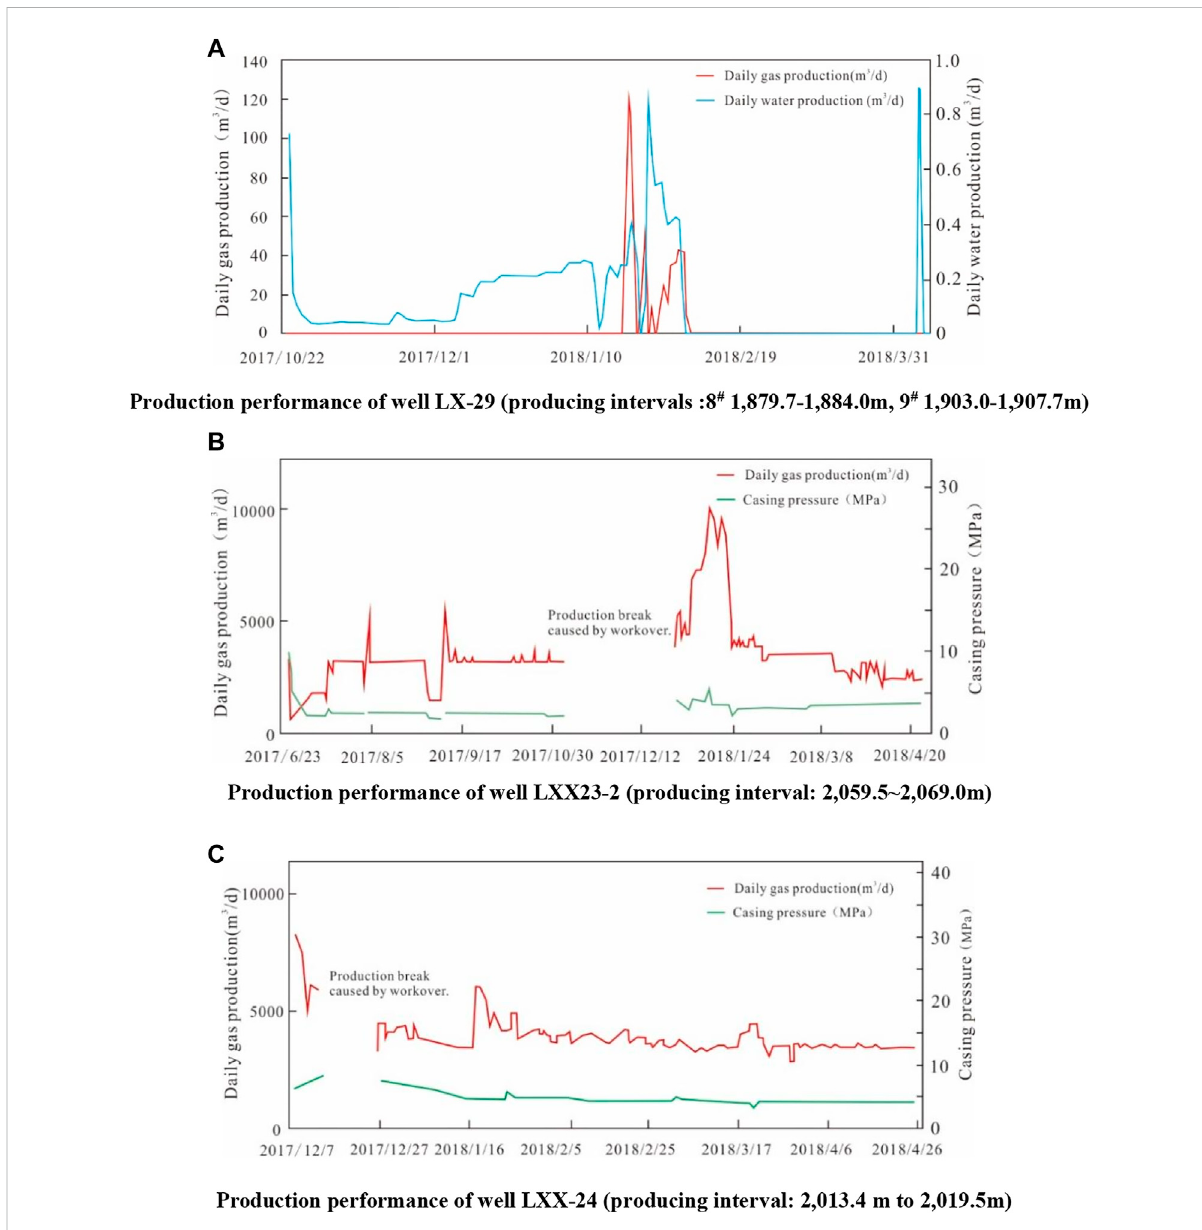
FIGURE 3 Production performance of CBM wells in Linxing CBM Block. (A) Production performance of well LX-29 (producing intervals :8 # 1,879.7- 1,884.0 m, 9 # 1,903.0-1,907.7 m). (B) Production performance of well LXX23-2 (producing interval: 2,059.5~2,069.0 m). (C) Production performance of well LXX-24 (producing interval: 2,013.4 m to 2,019.5 m). (All the three wells are producing from coal seams 8+9 # in Taiyuan Formation. Wells LXX23-2 and LXX24 had no water production. These wells were put on production after hydraulic fracturing without water pumping